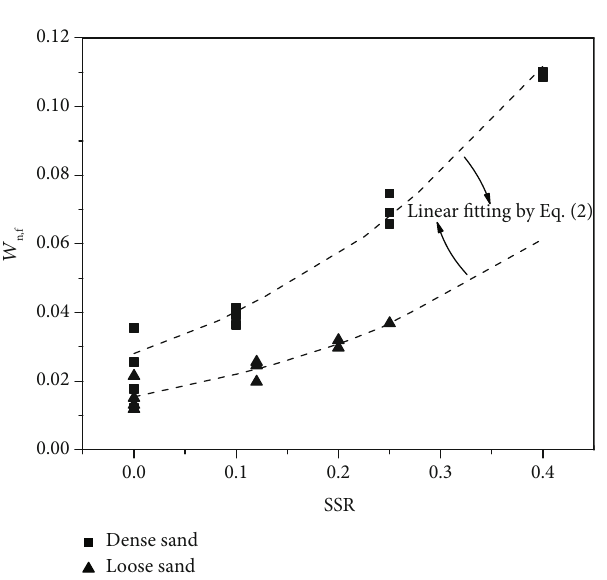
Figure 12: Comparison of measured and predicted values of dissipated